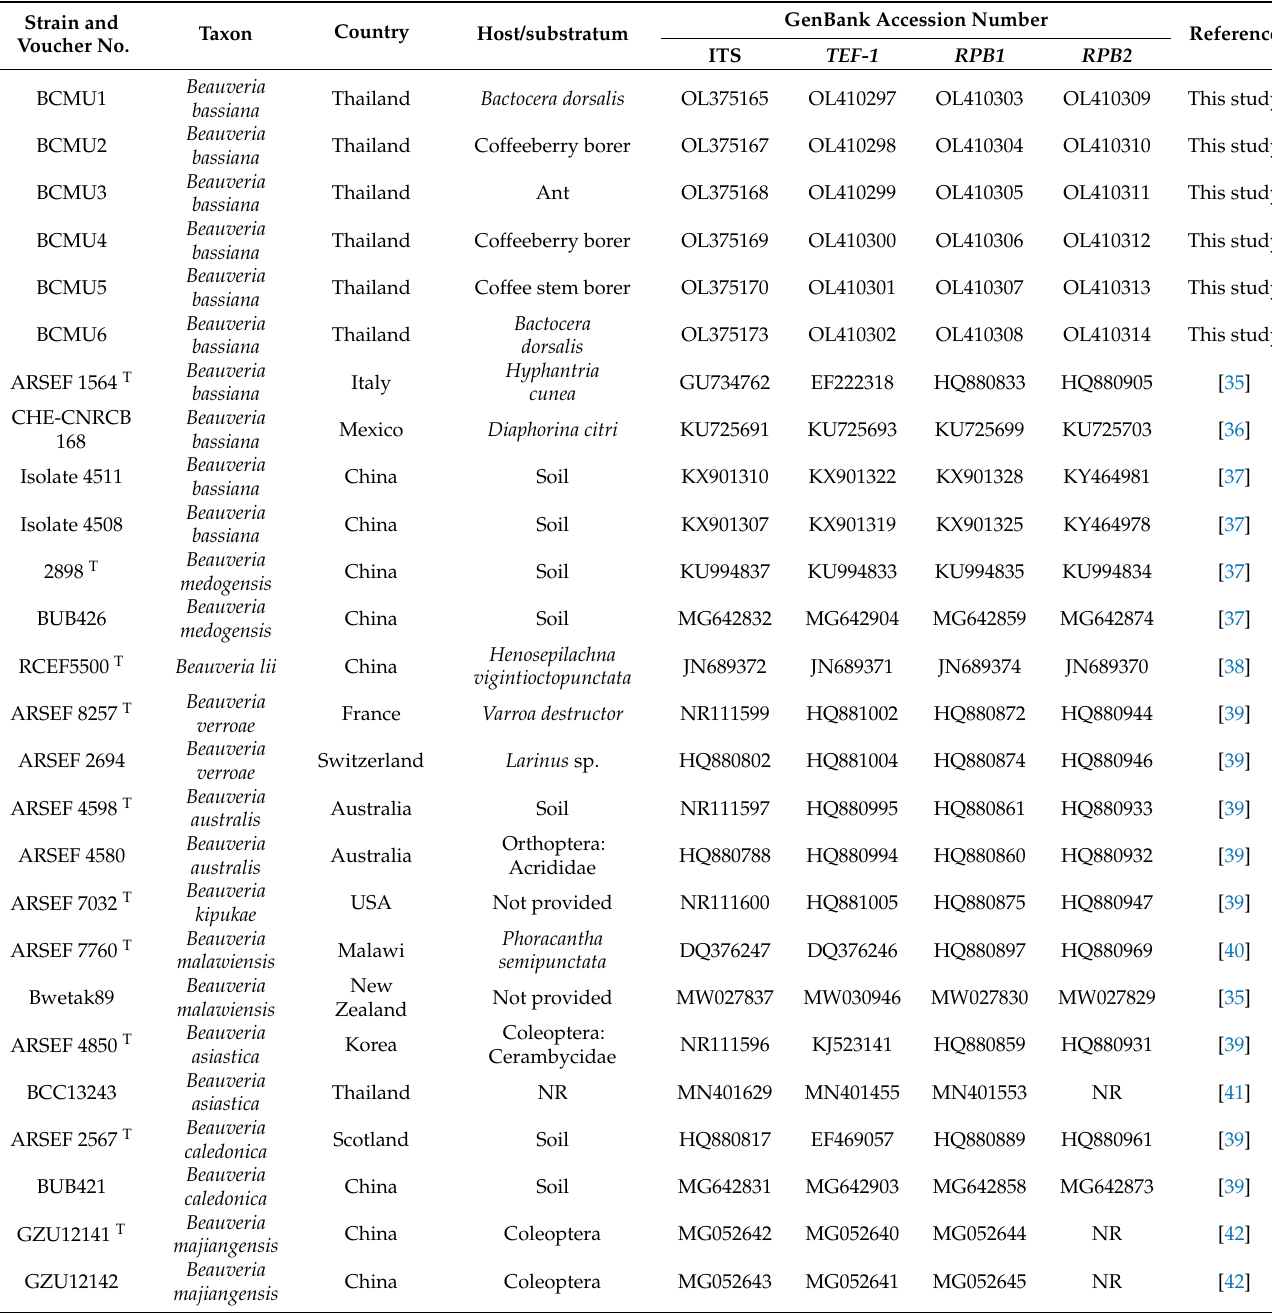
Table 2. GenBank sequences data of fungal isolates used in this